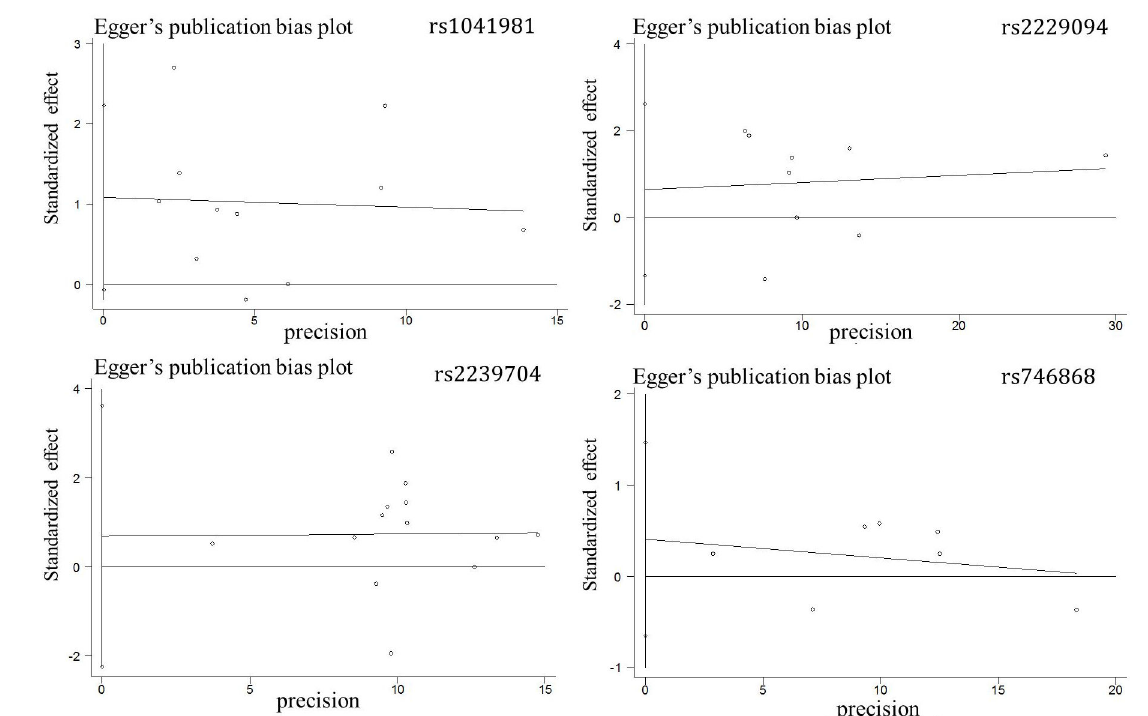
Figure 5. Funnel plots of LTA polymorphisms and cancer risk data for publication